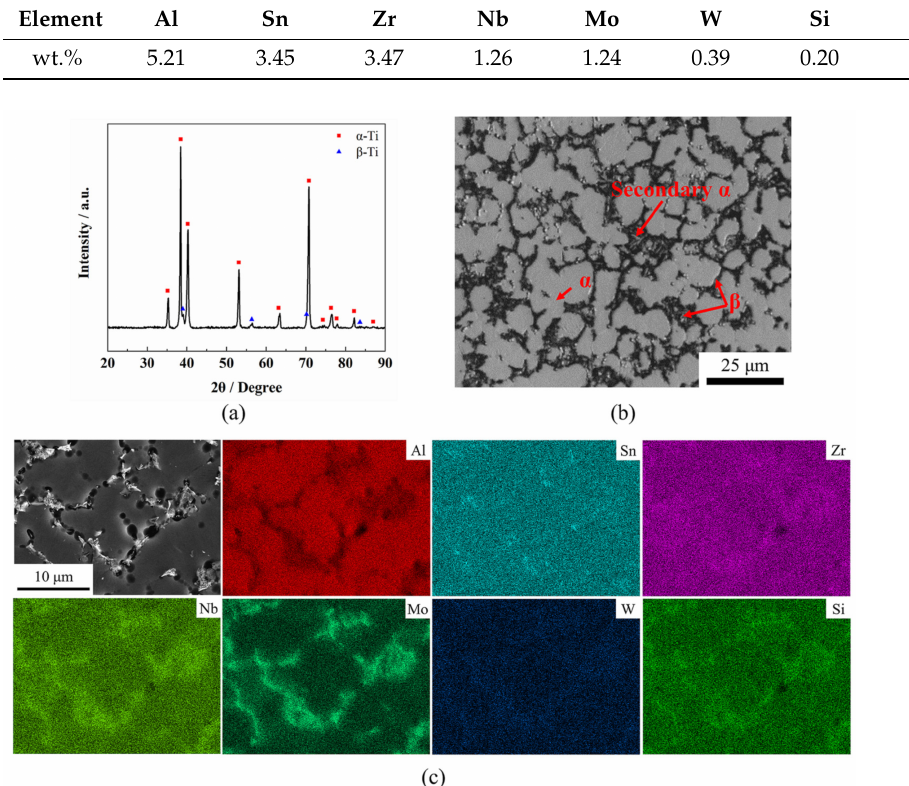
Table 1. Chemical composition of the TC31 titanium alloy.